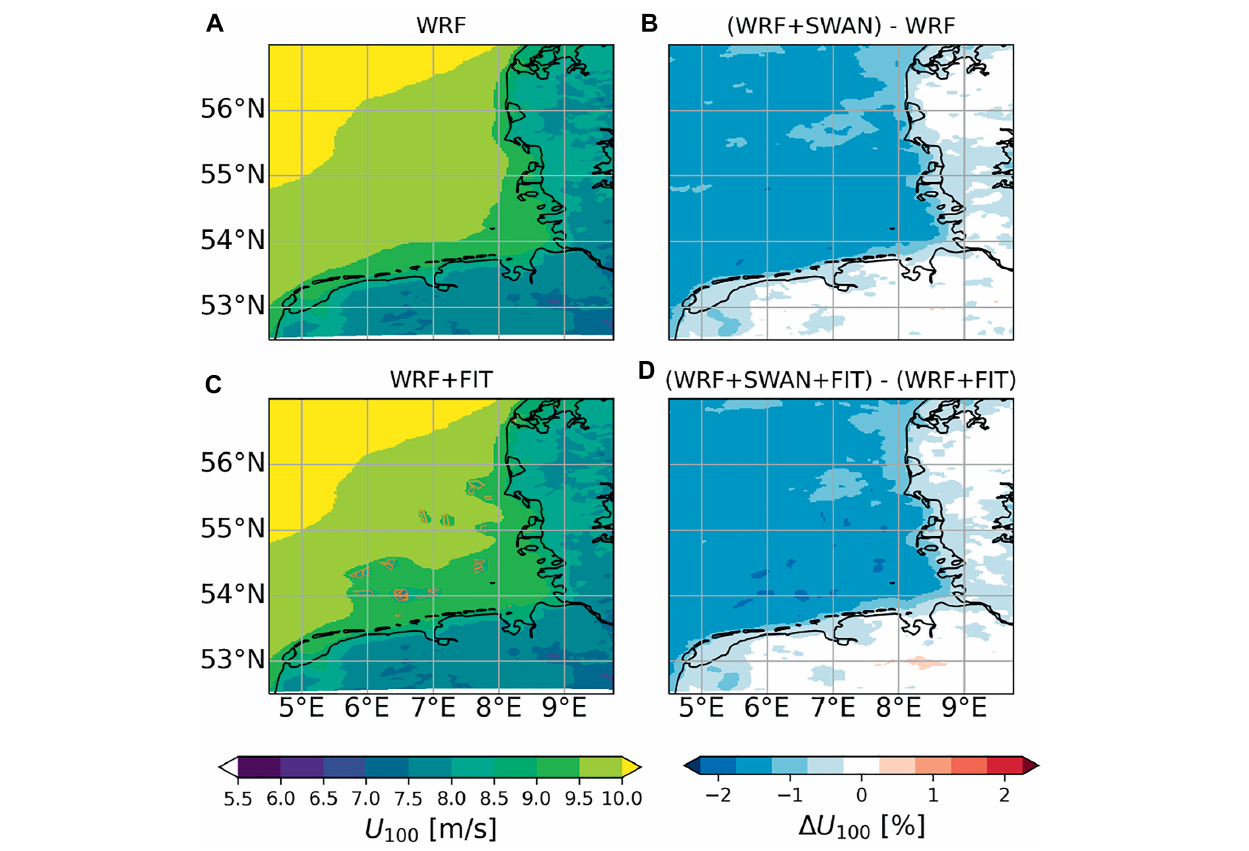
FIGURE 11 | (A,B) Simulated long-term wind speed at 100 m height for (A) WRF and (C) WRF + FIT and (B,D) relative reduction of wind speed based on (B) (WRF + SWAN)-WRF and (D) (WRF + SWAN + FIT)-(WRF + FIT) both normalized by the respective subtrahend.